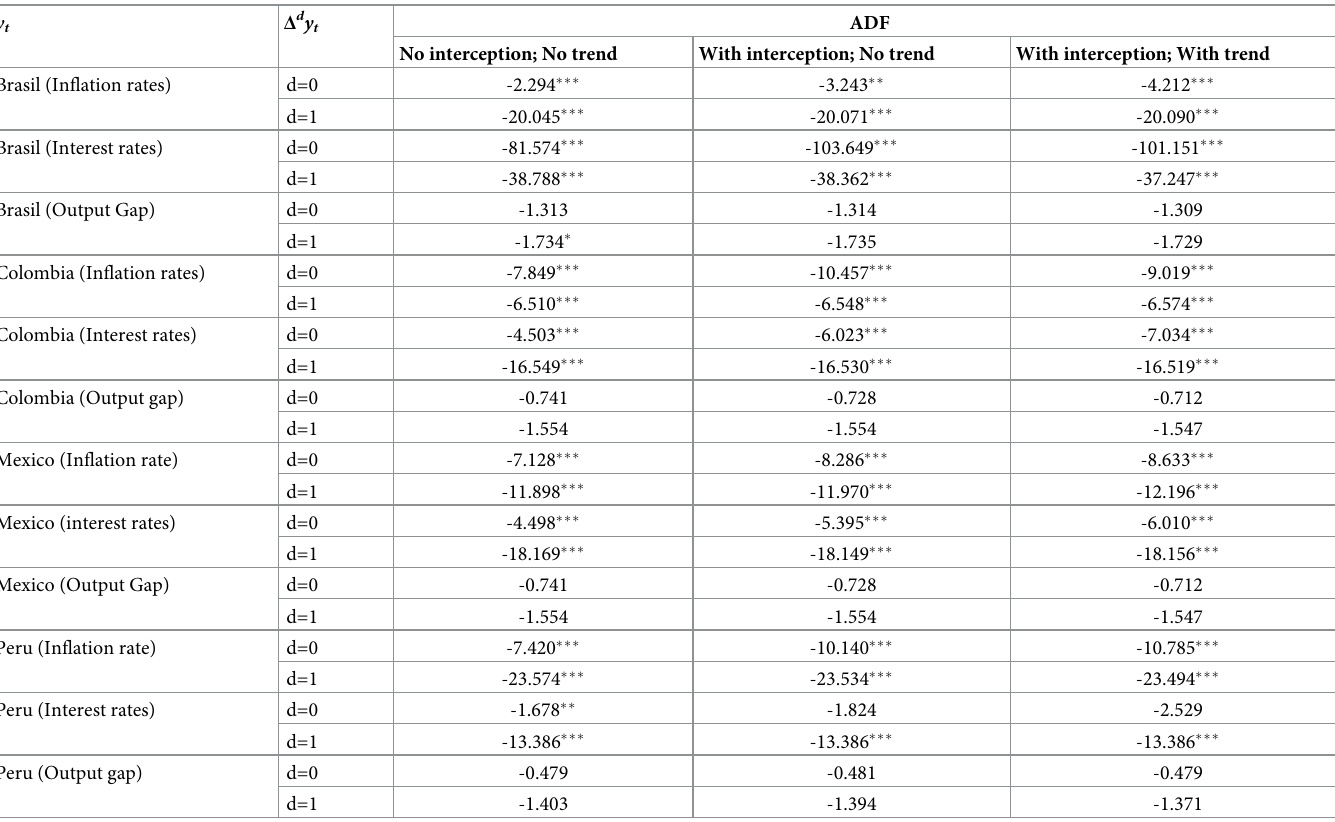
Table 3. Augmented Dickey-Fuller (ADF) Statistics of the series studied in this